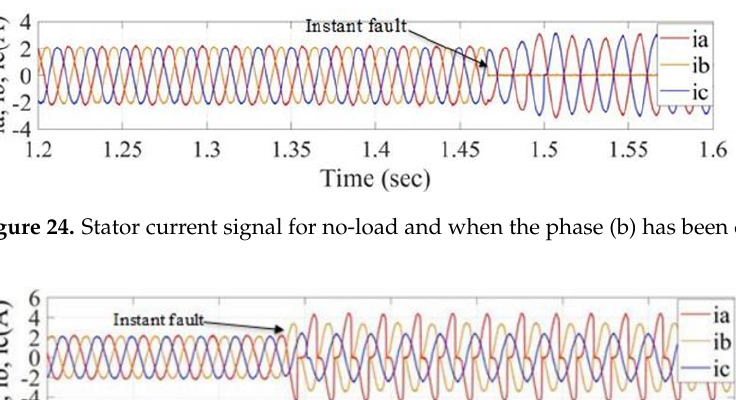
Figure 23. The implemented system ( a ) Block diagram, and ( b ) practical implementation Figure 24. Stator current signal for no-load and when the phase (b) has been disconnected/lost. of the protection system.